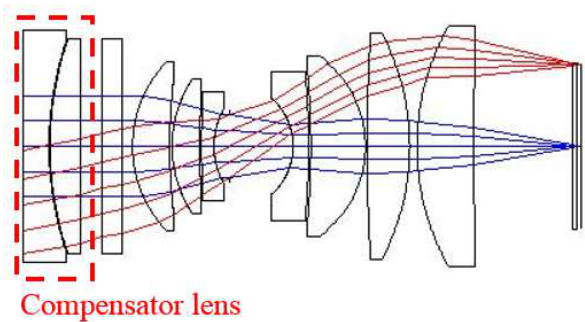
Figure 6. Optical system’s structure with compensation lens.